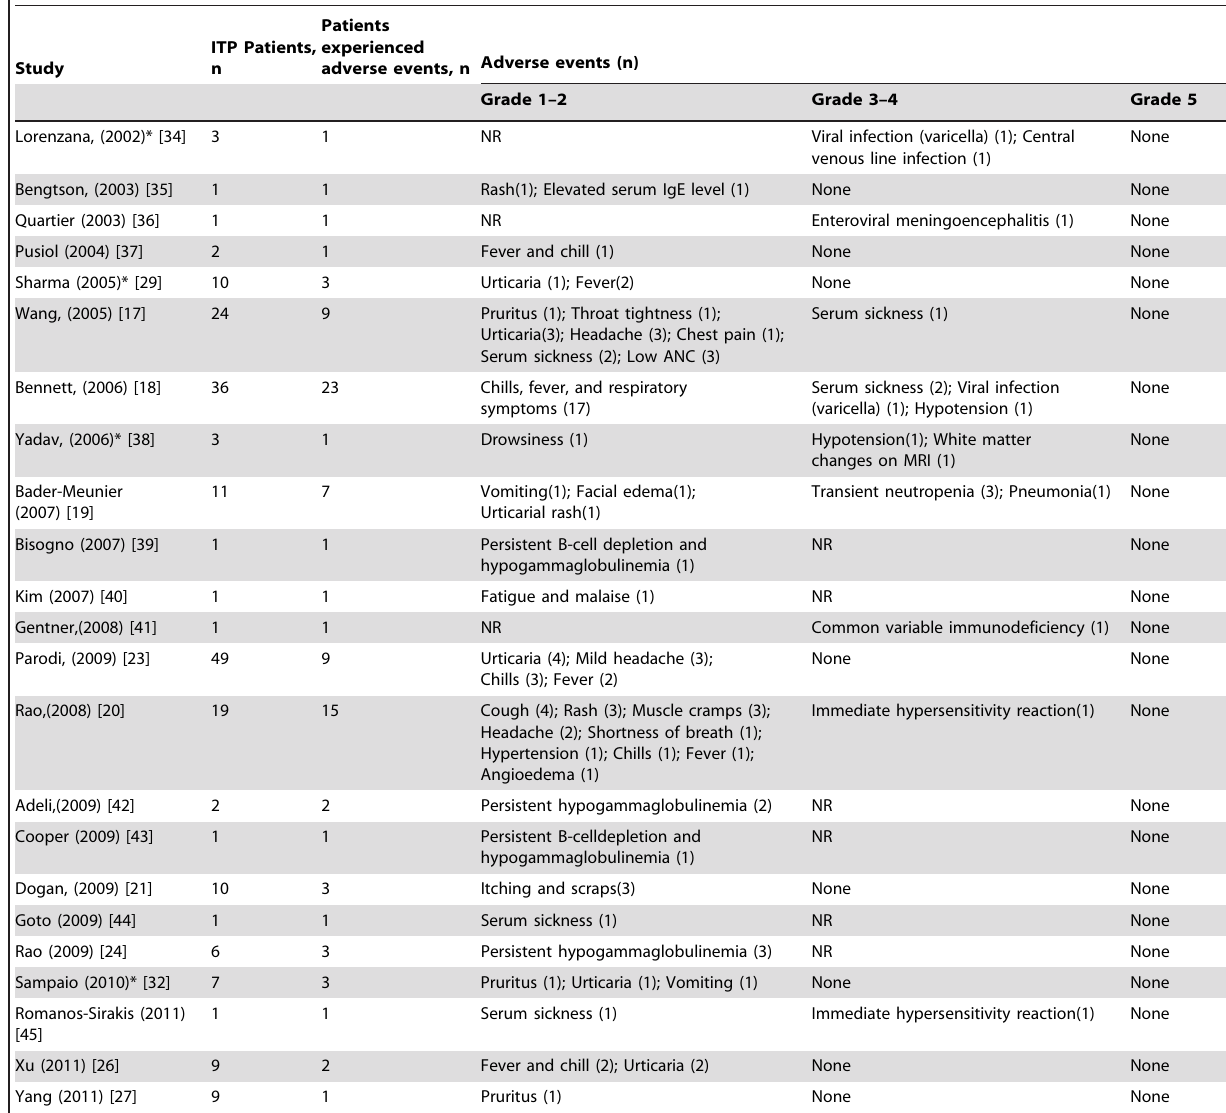
Table 3. Adverse events observed after rituximab infusion in children with